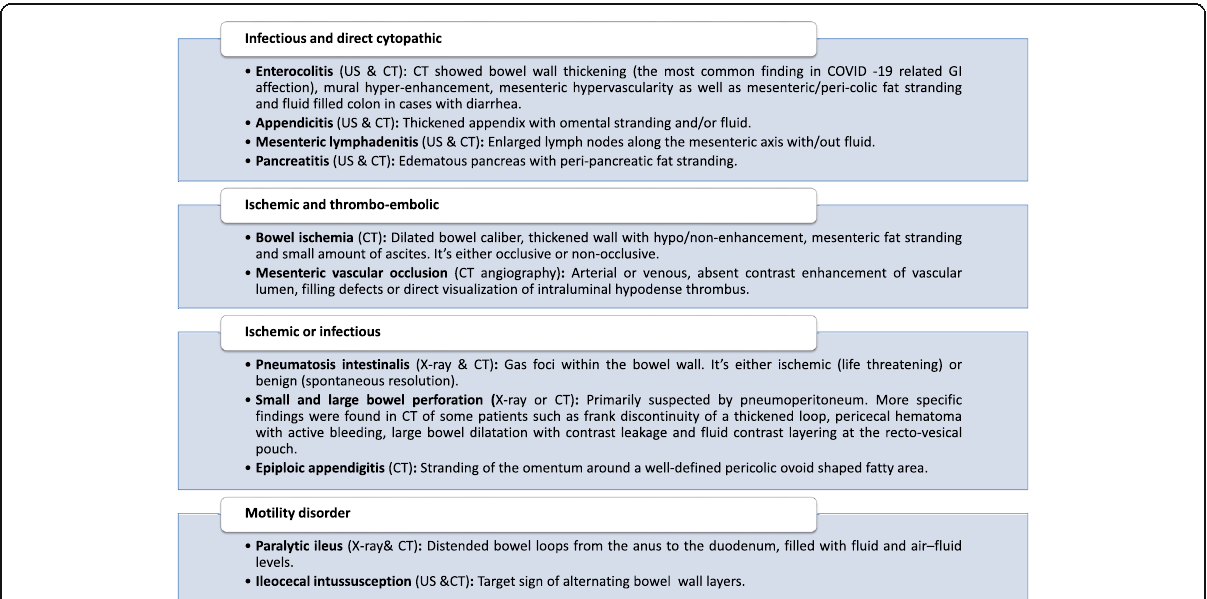
Fig. 4 Abdominal radiological findings of COVID-19-associated GI symptoms. CT, computed tomography; US, ultrasound; GI,